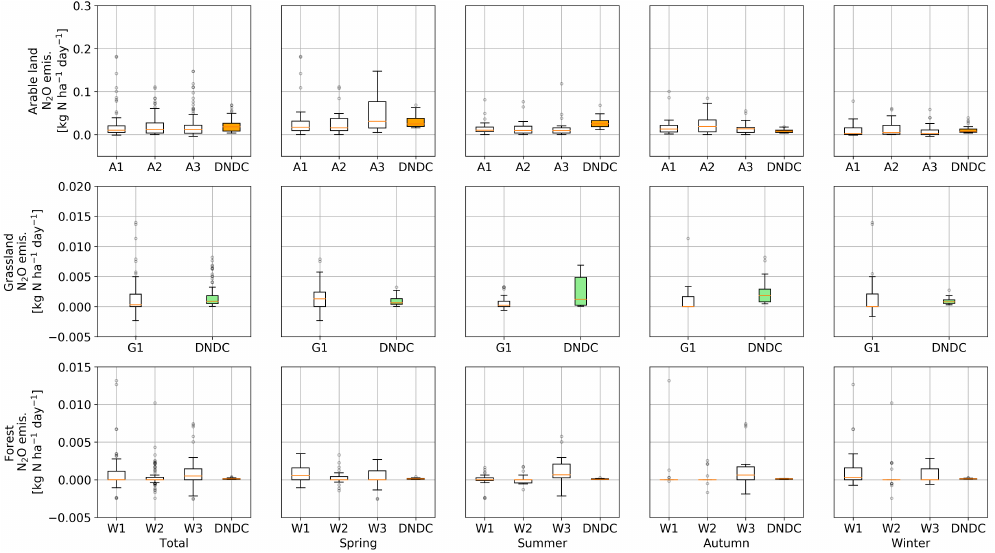
Figure 3. Observed and modelled N 2 O emissions for spring (21 March–20 June), summer (21 June–20 September), autumn (21 September– 20 December) and winter (21 December–20 March).